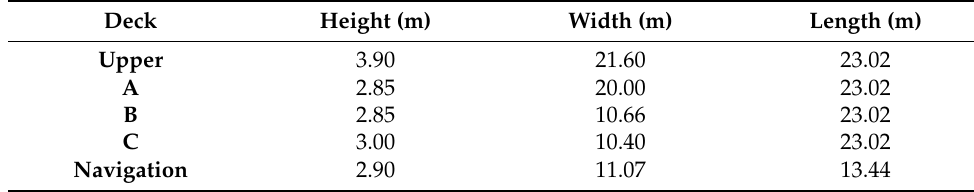
Table 1. Deck specifications.